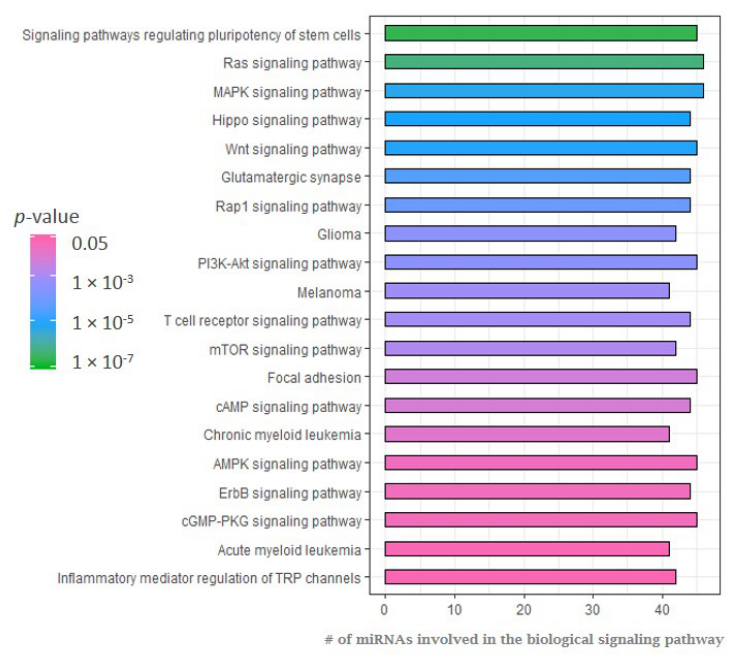
Figure 3. Enriched KEGG signaling pathways for the downregulated miRNAs represented in Figure 2 ordered by p -values (low to high). Signaling pathways were identified by the web-based computational tool DIANA-miRPath [50]. Cancers 2020 , 12 , x